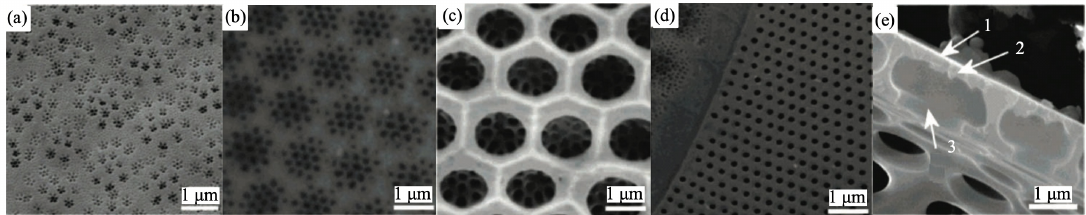
Figure 2. ( a – c ) SEM images of the different layers of a single valve of a Coscinodiscus sp. diatom frustule: cribellum ( a ), cribrum ( b ), and foramen ( c ). ( d ) a detail of the girdle band area; ( e ) sectional view of the valve. Arrows indicate : cribellum (1), cribrum (2), and the internal plate (3). Adapted with permission from Ref. [28]. Copyright 2007 American Chemical